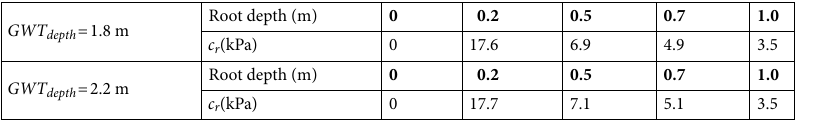
Table 2. Parameters used for the bank stability analysis using the BSTEM. c r = root cohesion, GWT depth = depth to groundwater table. Significant values are in bold.